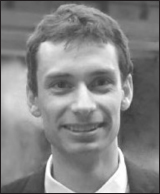
Dr. Matthias Lavens